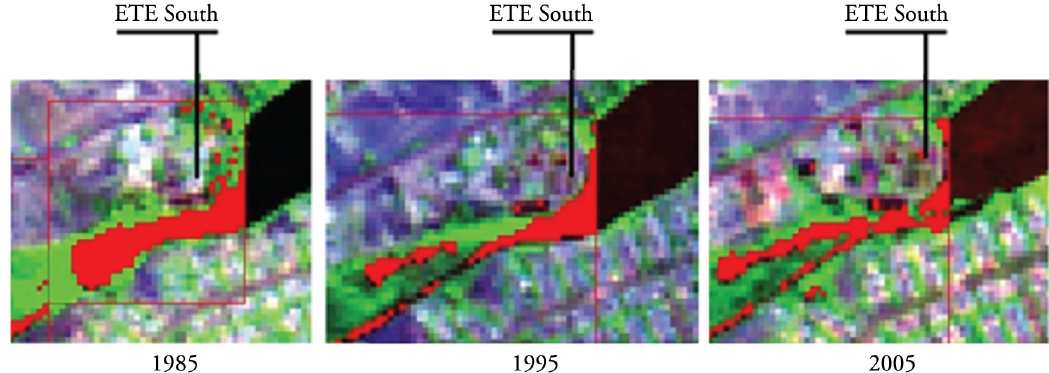
Figure 4. Growth between years 1985, 1995 and 2005. The red spots are water area and the green spot